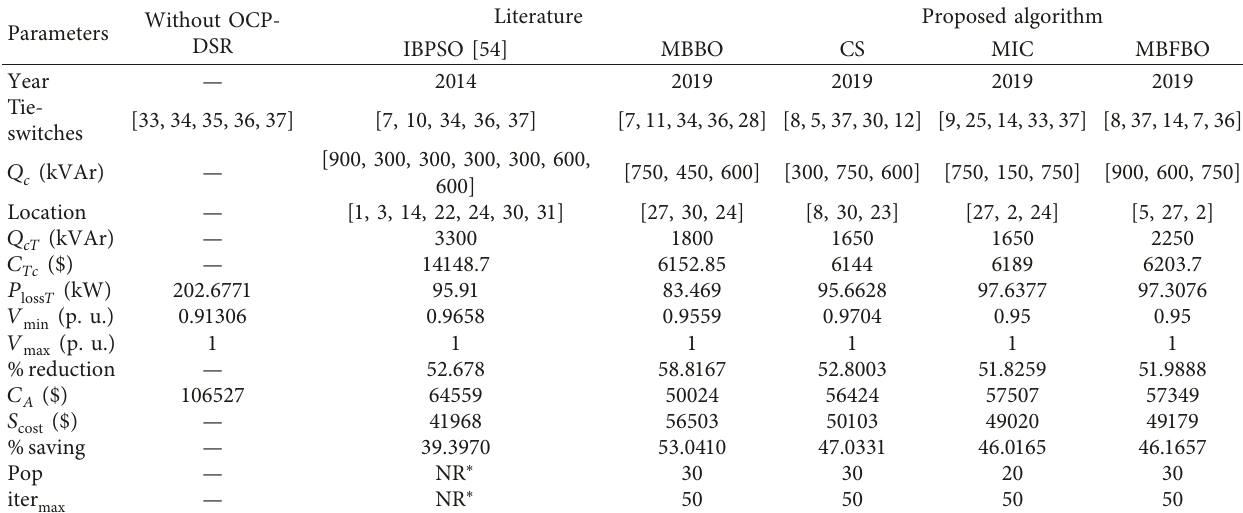
Table 9: Results and comparisons of IEEE-33-bus RDS without and with dual OCP-DSR